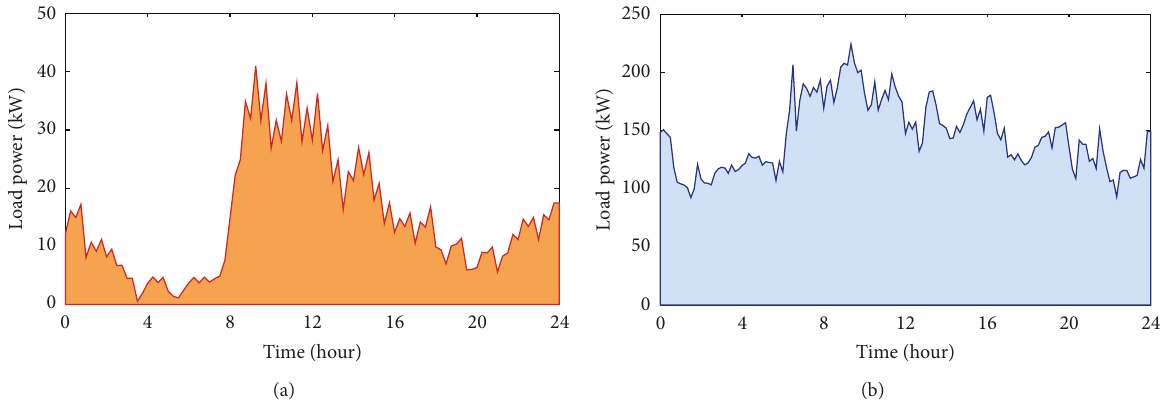
Figure 1: Residential load profile (a). Industrial load profile (b).